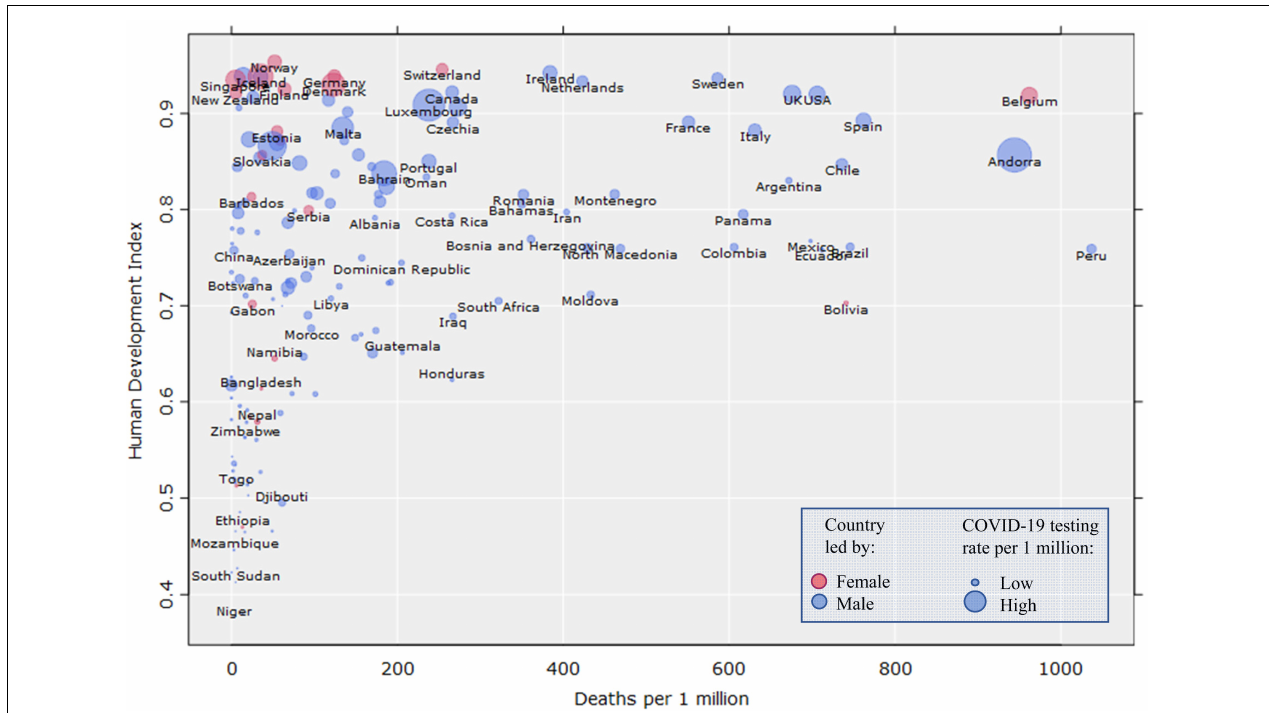
FIGURE 2 | COVID-19 deaths per 1 million in relation to the Human Development Index ( N = 168, r s = 0.51). Data points are colored according to the sex/gender of the country leader, and scaled to COVID-19 tests per 1 million. For the full data, see Supplementary Materials